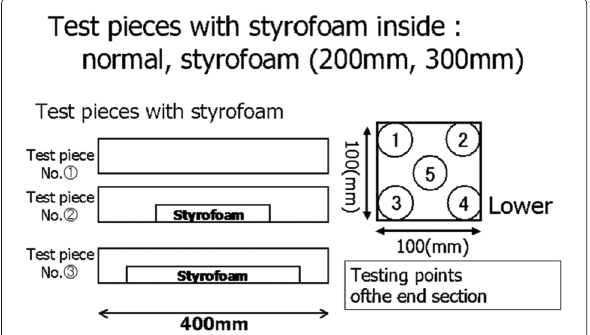
Fig. 4 Test pieces with styrofoam